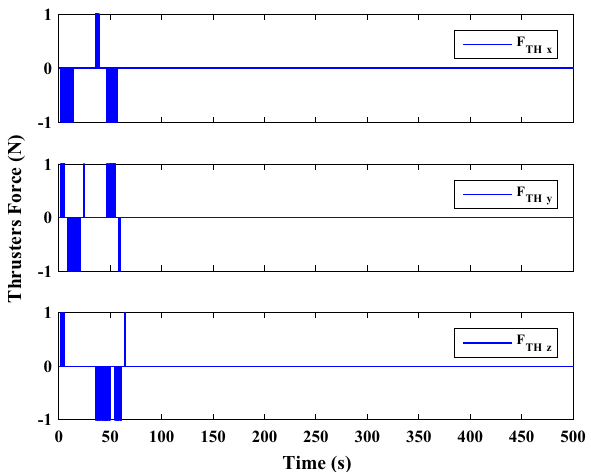
Figure 67. Scenario III: chaser’s thrusters force.